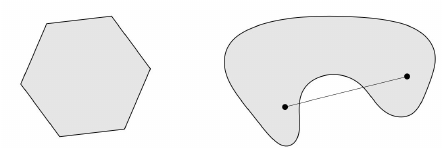
Figure 11. An example of convex and nonconvex sets. Left . The hexagon, which includes its boundary (shown darker), is convex. Right . The kidney shaped set is not convex, since the line segment between the two points in the set shown as dots is not contained in the